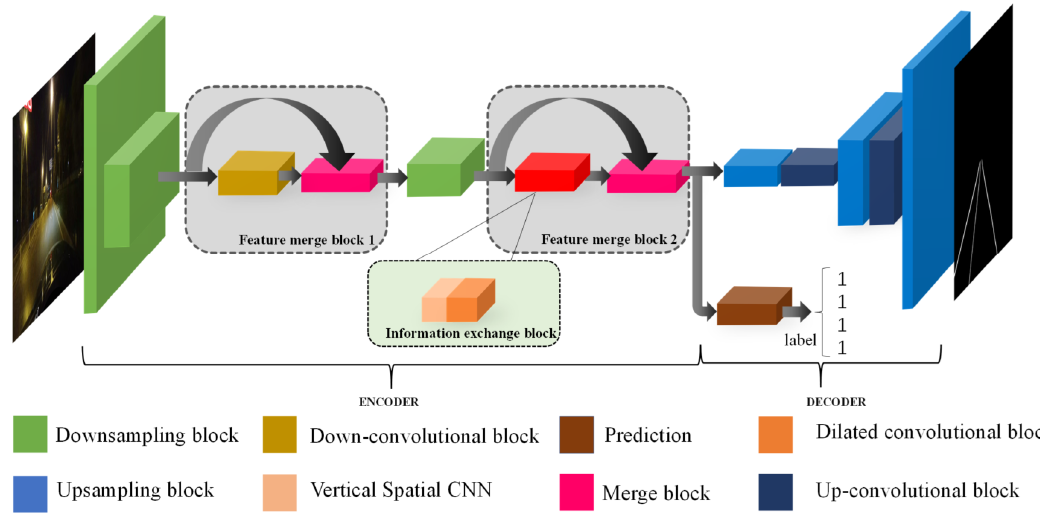
Figure 3. The architecture of the lane detection